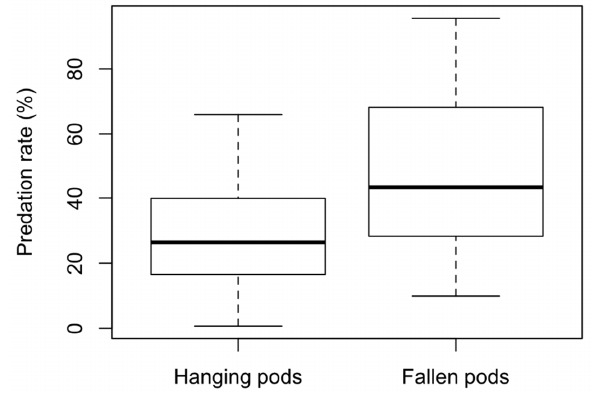
Figure 2. Predation rates (%) on seeds from Vachellia tortilis and V. raddiana trees hanging and fallen pods in Evrona Nature Reserve, southern Israel. For fallen pods, predation rate was corrected by subtracting the mean predation rate on hanging pods from the mean ground predation rate. The tick line indicates the median, the lower and upper side of the box corresponds, respectively, to the upper and lower quartiles, and the whiskers extend to 1.5 times the interquartile range.